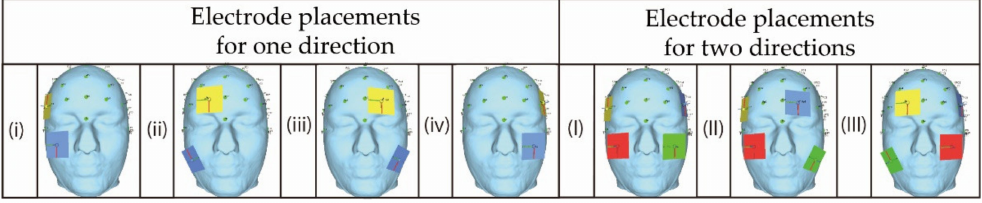
Figure 3. The electrode placement that stimulates the intended region on the eyeball surface [14]; the figures were produced by the authors in SimNIBS (accessed on 2 April